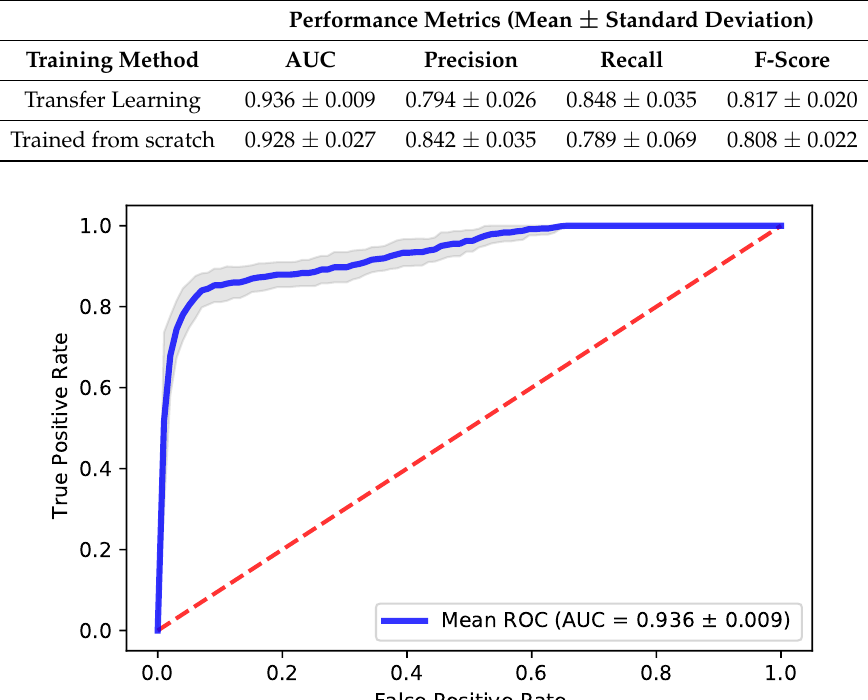
Figure 4. Averaged ROC curve for lung nodule malignancy classification using the transfer learning approach. The ROC curve is computed for each iteration, the arithmetic average is then calculated and represented by the blue line with a standard deviation represented by the gray shading area. The red dashed-line represents an at-chance classifier ROC